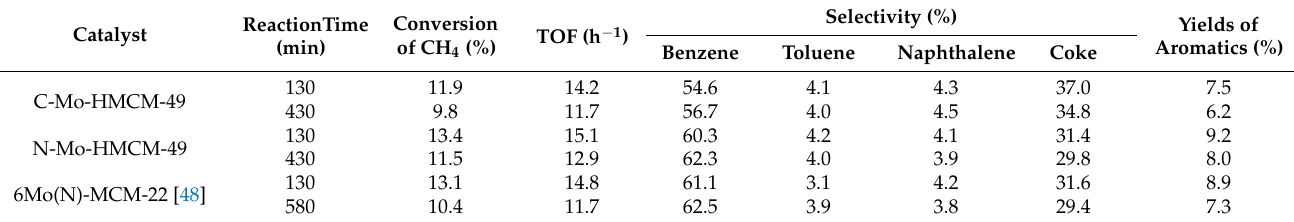
Table 3. The catalytic results of MDA over various catalysts.